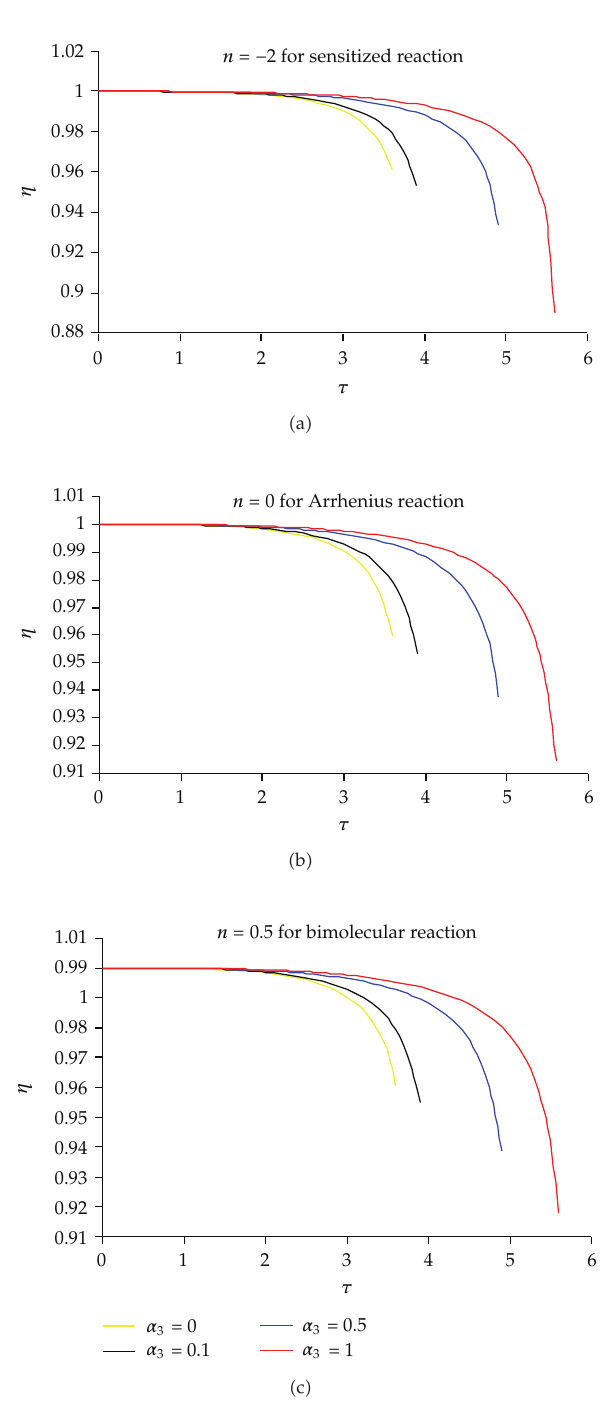
Figure 4: Variation of dimensionless combustible gas concentration with interphase heat exchange param- eters when n (cid:7) {− 2 , 0 , 0 . 5 }